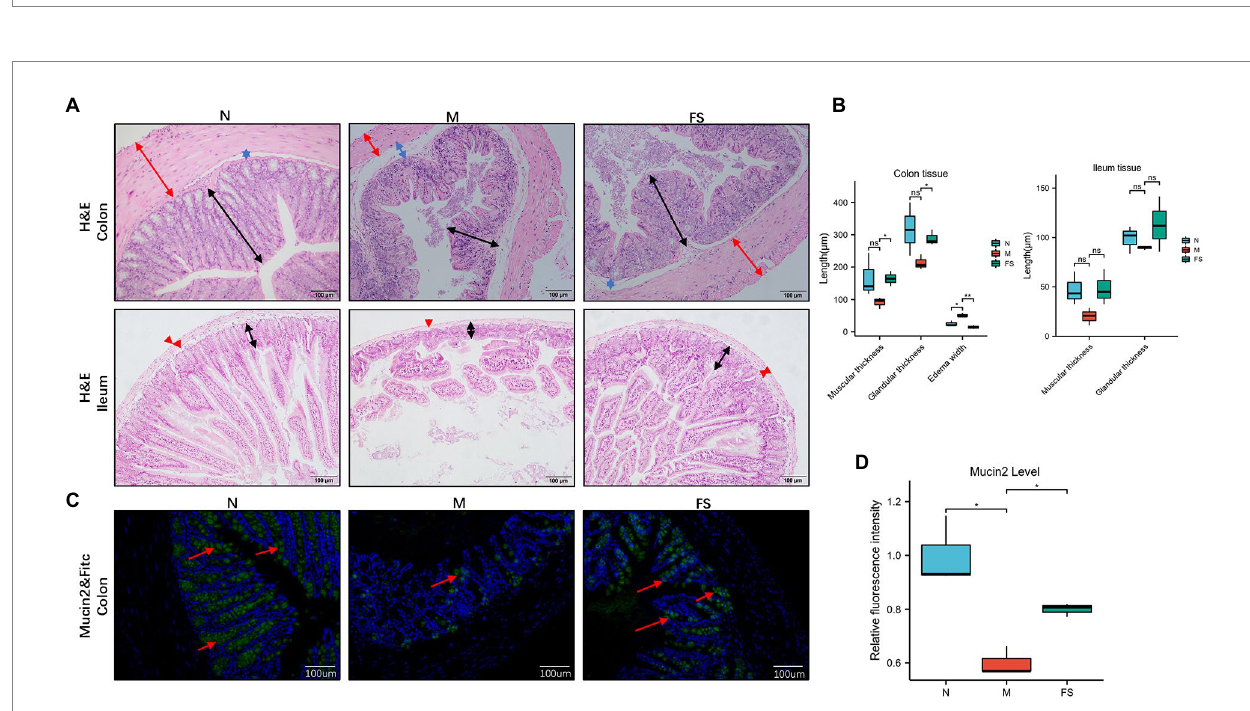
FIGURE 3 Postbiotic of Hawthorn-Probiotic help preserve the intestinal barrier. (A) Hematoxylin and eosin (H&E) staining in mice’s colon and ileum tissue; (B) muscle thickness, glandular thickness, edema width in colon; Muscle thickness, glandular thickness in ileum; (C,D) Mucin2 and FITC staining in colon tissue, Mucin2 is green, FITC is blue. NS; * p < 0.05; ** p < 0.01; *** p < 0.001.